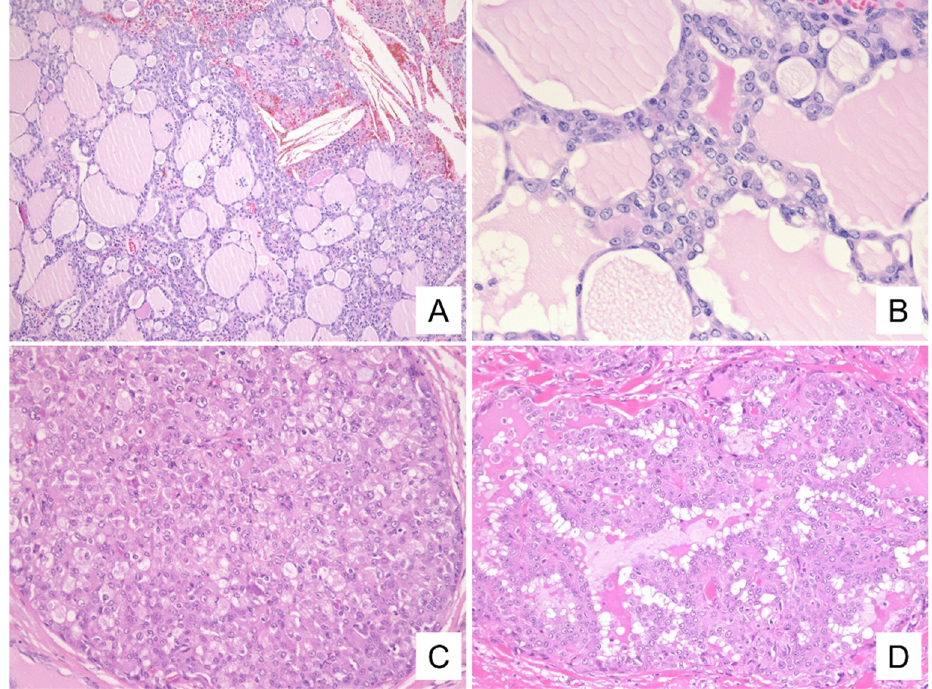
Figure 4. Histologic findings. Histologically, the tumor shows ( A ) follicular-like structures of various sizes resembling thyroid tissue and cystic or microcystic structures. ( B ) The lumens of the follicular structures are filled with eosinophilic, homogeneous secretory materials mimicking the thyroid colloid. The neoplastic cells have vacuolated cytoplasm and enlarged nuclei with small and distinct single nucleoli. In addition, ( C ) microcystic/solid and ( D ) papillary structures are seen (( A – D ): H&E staining. ( A ): case 1, ×40, ( B ): case 1, ×400, ( C ): case 2, ×200, ( D ): case 4, ×400).